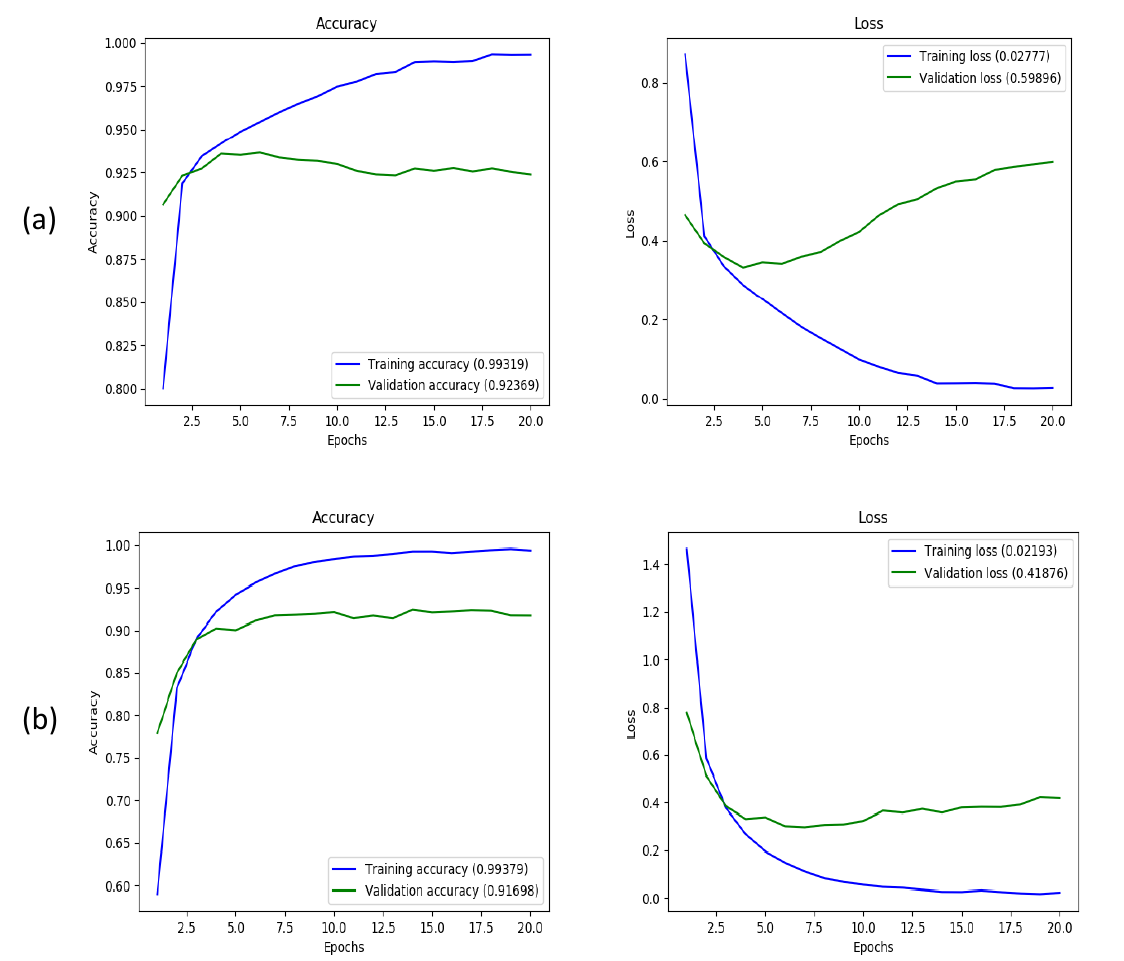
Figure 7. Accuracy and Loss of CNN model. ( a ) Training and validation results on CLAPTCHA data set. ( b ) Training model on both data sets. Both ( a , b ) were garnered from 20 epochs and trained on 60,000